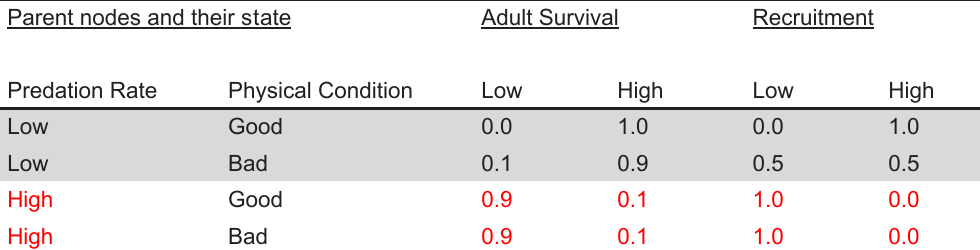
Table A3. Conditional probability table for nodes adult survival and